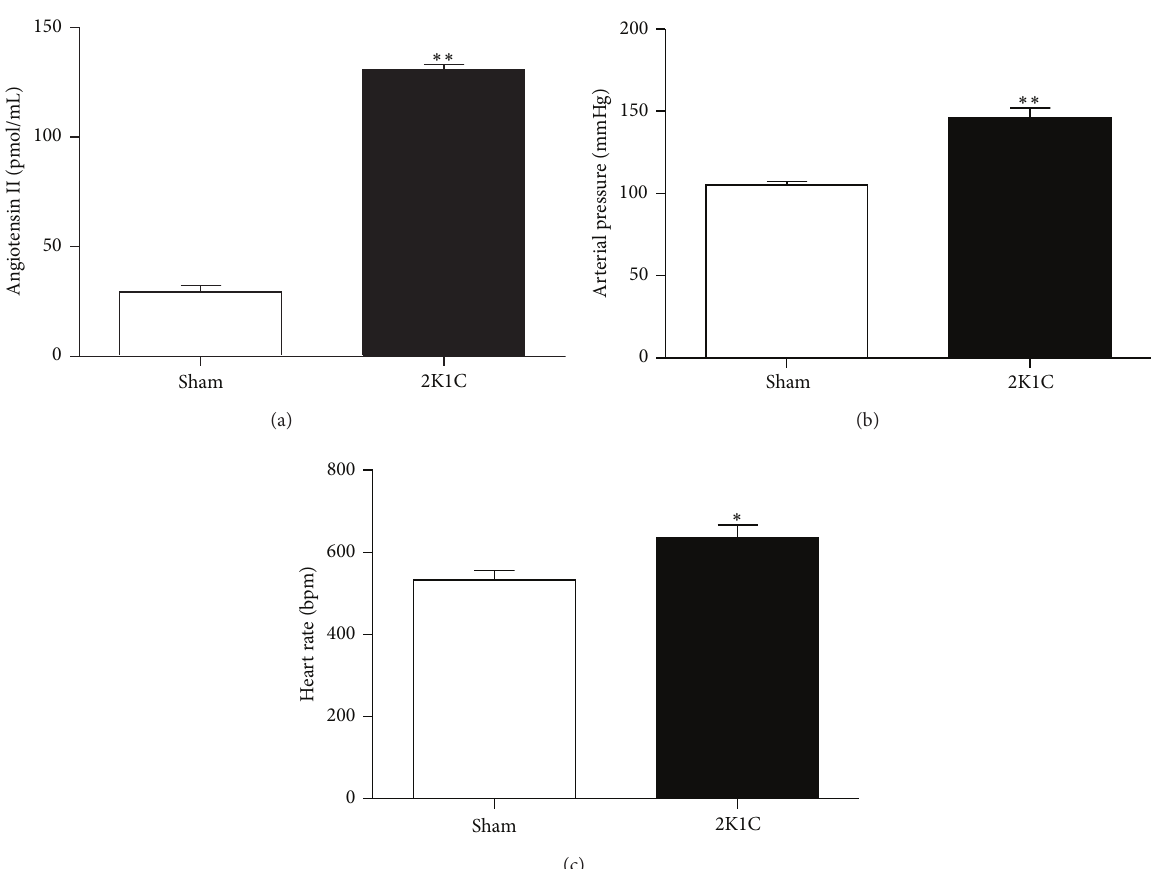
Figure 1: Bar graphs demonstrating resting mean arterial pressure, heart rate, and plasma angiotensin II values in conscious Sham ( 𝑛 = 5 ) and renovascular hypertensive (2K1C, 𝑛 = 5 ) mice. Values are the means ± SEM. ∗ 𝑃 < 0.05 and ∗∗ 𝑃 < 0.01 versus the Sham group (Student’s 𝑡 test for independent